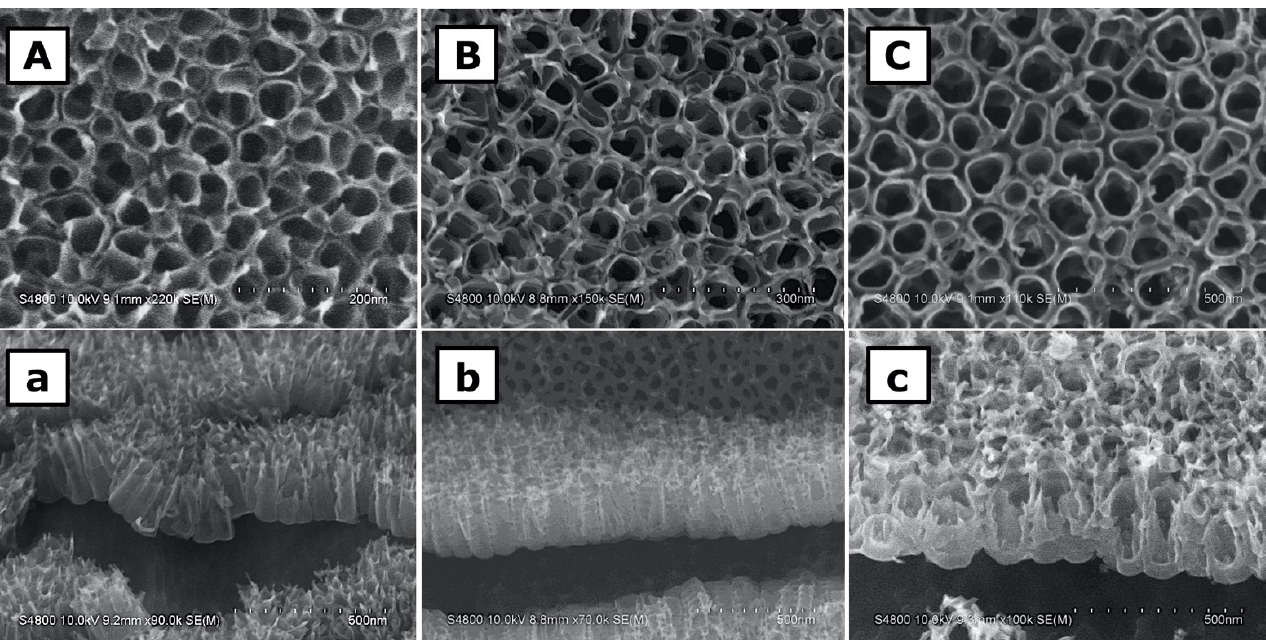
Figure 1. FE ‐ SEM images showing top view and cross ‐ section of TiO 2 nanotube arrays anodized at ( A , a ) 10 V, ( B , b ) 15 V, and ( C , c ) 20 V. Table 3. Mean values and standard deviations (SD) of the specimens’ surface roughness parameters recorded with a 3D optical profiler in micrometers. Roughness average Ra is the arithmetic mean of the absolute values of the roughness profile ordinates. Rp is the maximum peak height of the roughness profile within one sampling length. Root mean square deviation Rq indicates the root mean square along the sampling length. Rt is the vertical distance between the maximum profile peak height and the maximum profile valley depth along the evaluation length. Rv is the maximum valley depth of the roughness profile within one sampling length (previously, the parameter symbol Rm was used in place of Rv).